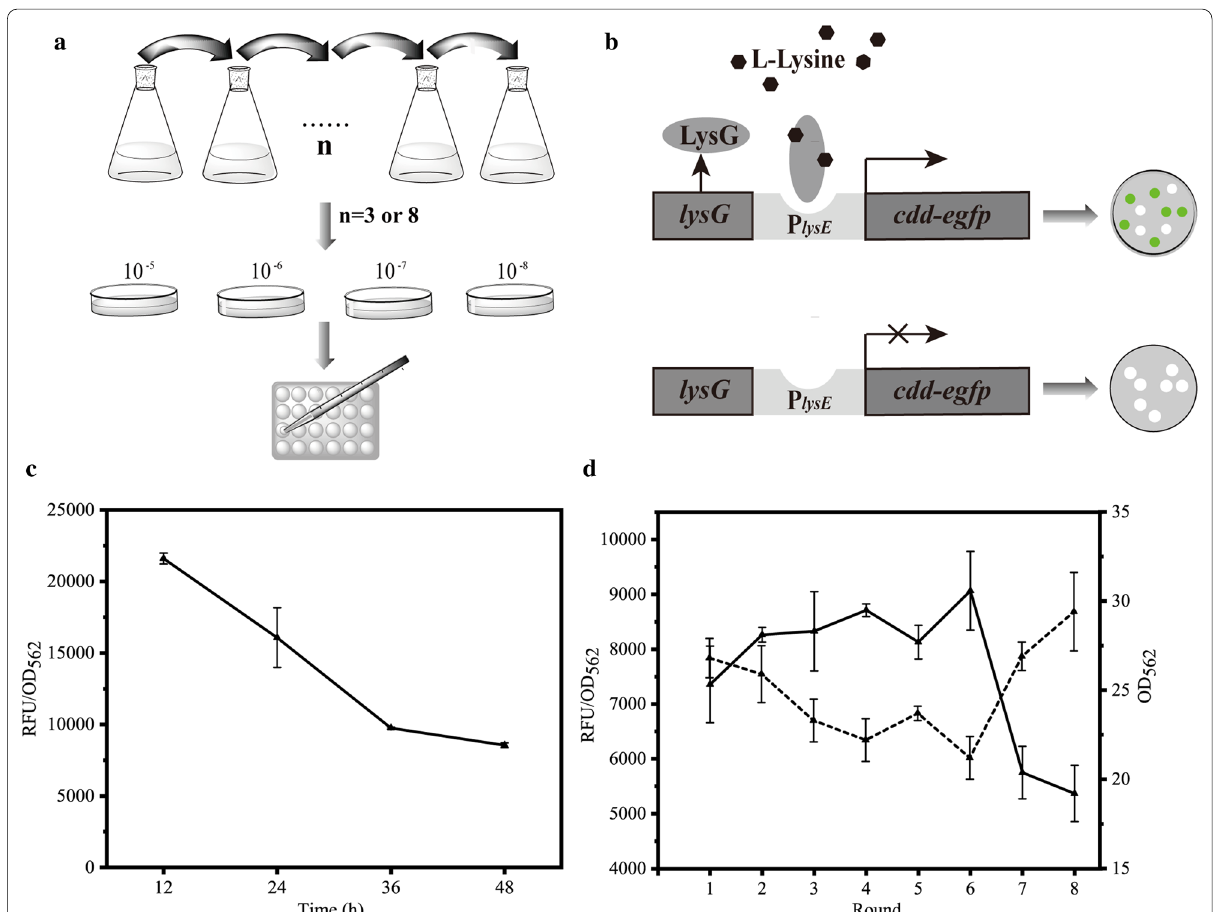
Fig. 1 The Lys-biosensor based programming ALE process. The Lys biosensor senses the intracellular Lys concentration and regulates the expression level of the evolution actuator, thereby controls and indicates the evolution process. a Schematic of programming ALE process. The evolutionary strain SZ06/pMK was repeatedly and continuously cultured for several rounds in the same medium, the evolution process was ceased and the evolved cells were harvested when the relative eGFP fluorescence intensity no longer reduced significantly. Then, 22 single colonies were picked randomly for purification, and they were cultured in 24 deep-well plate. b The work diagram of pMK. When Lys concentration is higher, the biosensor was activated, thereby activating the expression of cdd and egfp and increasing the mutation rate and the eGFP fluorescence intensity of cells. When Lys concentration is lower, the Lys biosensor will not be activated, the relative eGFP fluorescence intensity will be decreased and the evolution process was ceased. c The change of relative eGFP fluorescence intensity in the 3 rd round. d The relative eGFP fluorescence intensity (solid line) and biomass (dotted line) of SZ06/pMK at 48 h of each